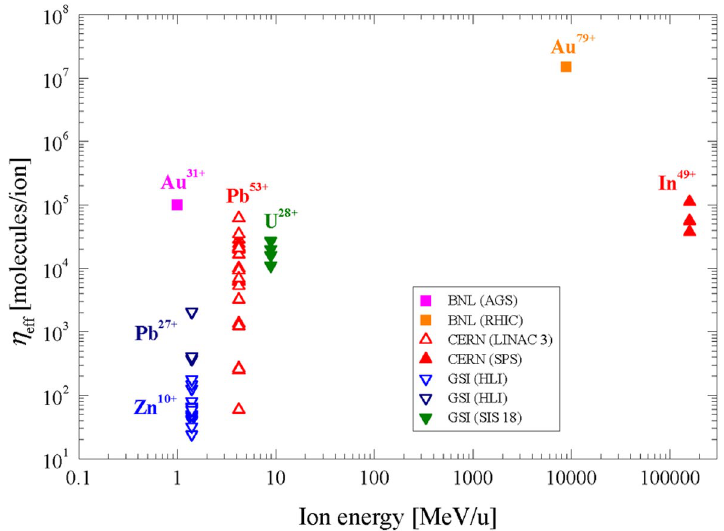
FIG. 7. (Color) Overview of heavy-ion induced desorption data including the SPS measurements with In 49 (cid:1) ions at 158 GeV = u . The measurements were made at CERN [1,2], GSI [3,4], and BNL [5,6]. The ion impact angles (perpendicular, mrad, (cid:4) rad ) of the experiments are